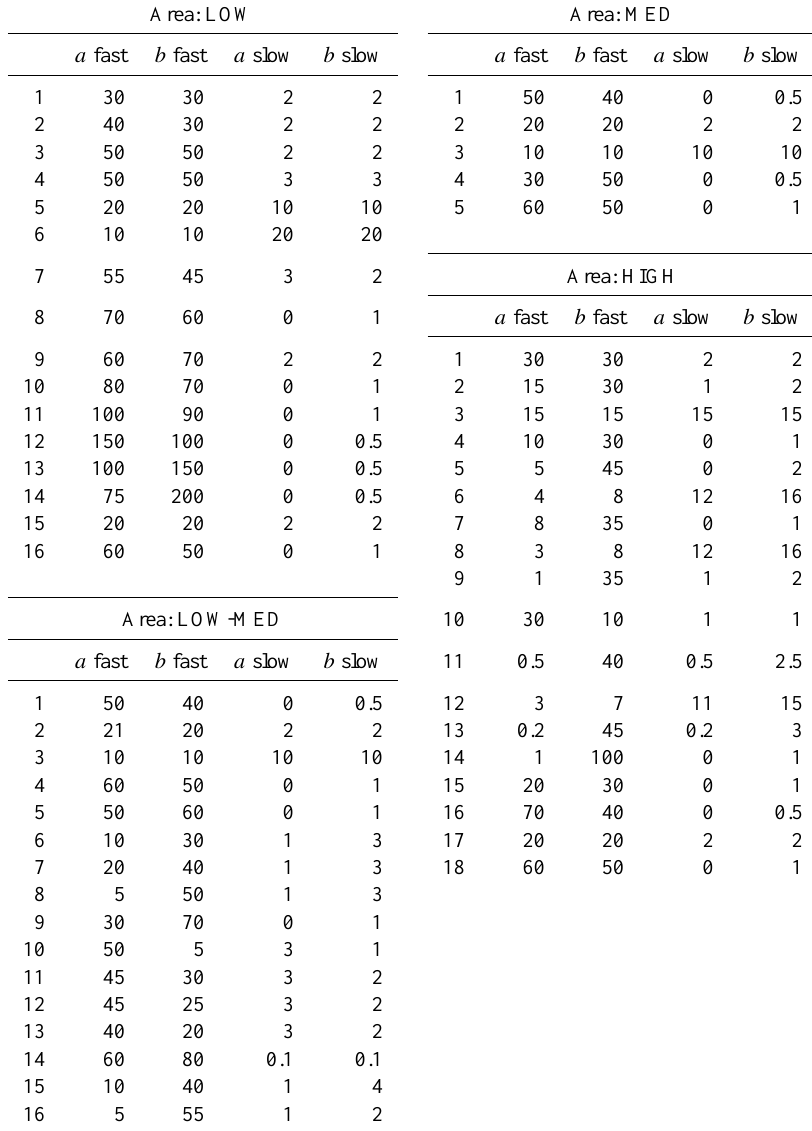
Table C1. All settings for Eq. (3) (main text) used to tune total land carbon and permafrost-carbon